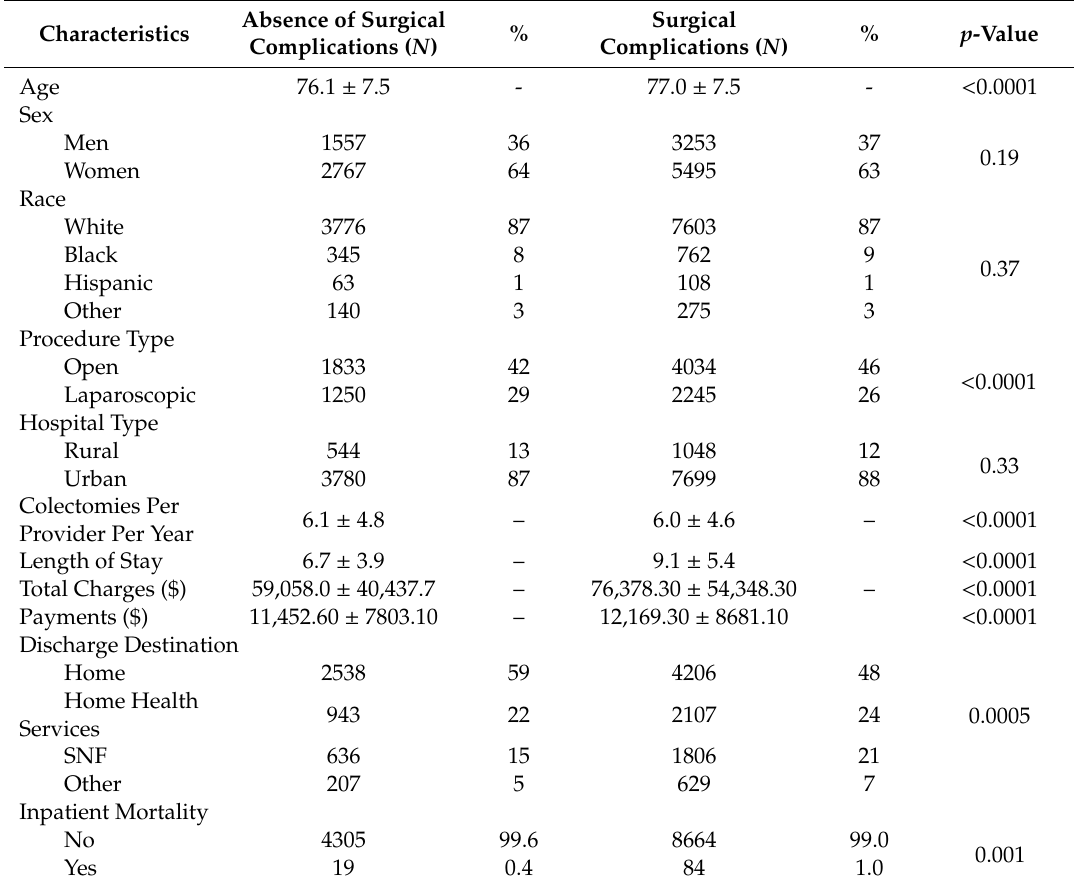
Table 1. Patent demographics, procedure type, and index hospital